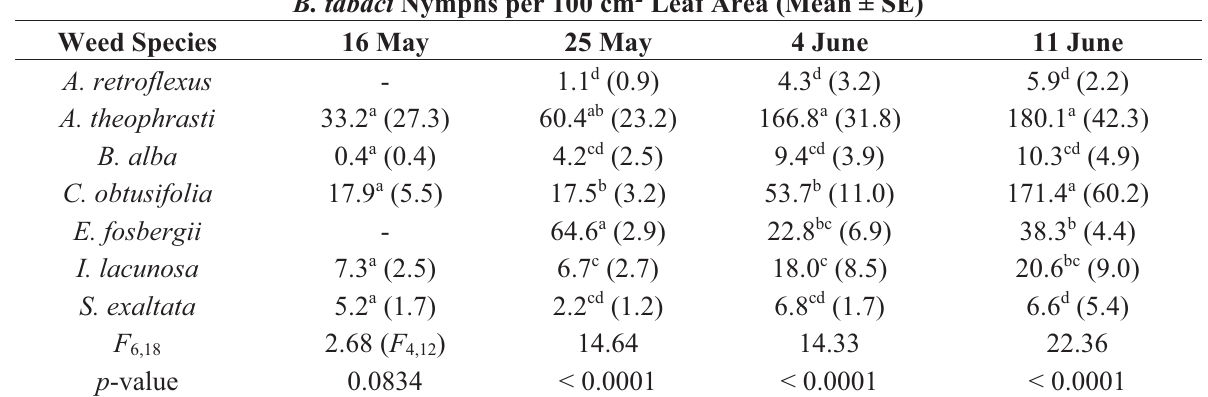
Table 2. Mean (±SE) B. tabaci nymph densities on whole plants of selected weeds in 2012. Means within a column followed by the same letter are not significantly different ( p < 0.05) by Fisher’s Protected LSD. Data were transformed log 10 (x + 1) prior to ANOVA; non-transformed means are